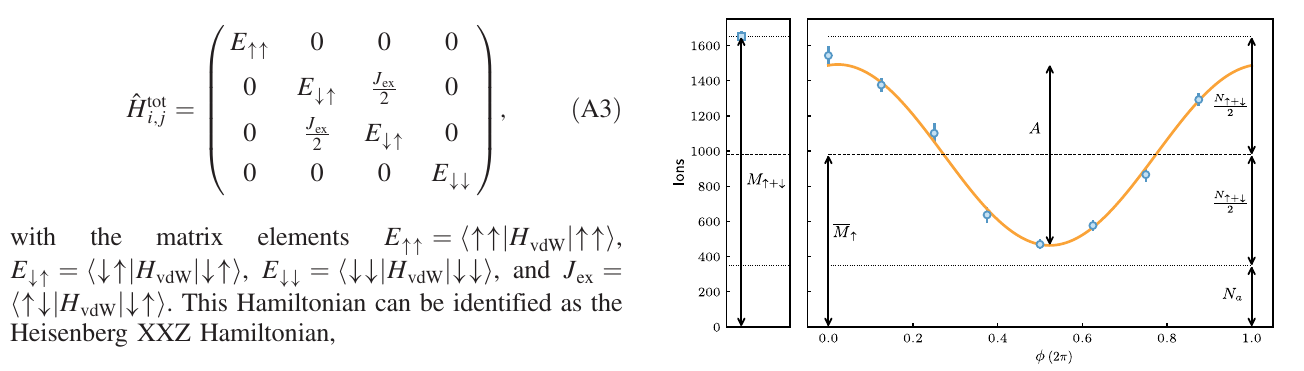
. Right: measurement of þ ↓ ¯ M ↑ . The